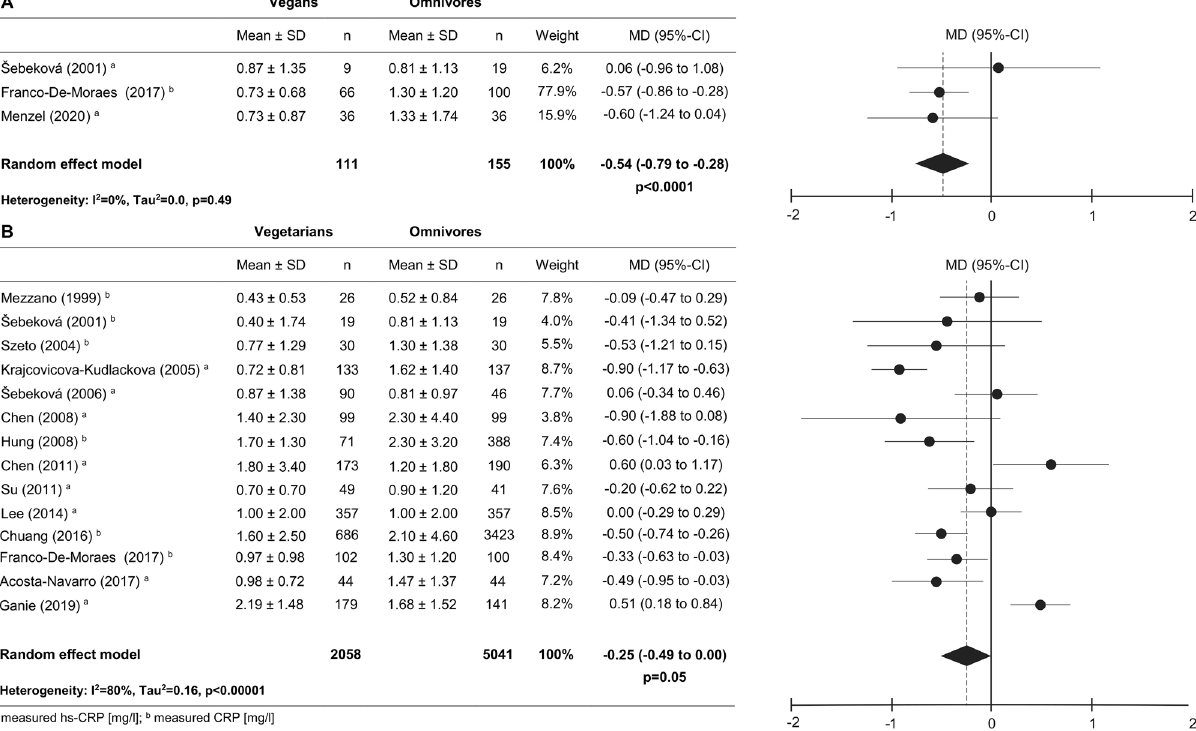
(Table 2). Among the different biomarkers, a meta-analysis was possible for CRP and TNF- ɑ in apparently healthy individuals. Regarding TNF- ɑ no significant differences between vegetarians and omnivores have been observed [mean difference 0.02 pg/ml, 95%-CI: − 0.39 to 0.43 pg/ml, p = 0.93]. However, meta-analysis revealed lower CRP levels in vegetarians compared to omnivores, showing a mean difference between vegetarians and omnivores of − 0.25 mg/l (95%-CI: − 0.49 to 0.00 mg/l; p = 0.05) (Fig. 2B). The generated funnel plot for CRP showed no evidence for publication bias (Supplemental Figure S1). In addition, also different statistical methods e.g. Egger regression or Funnel plot regression showed no evidence for publication bias (Supplemental Table S2). Interest- ingly, the association between vegetarian diet and CRP is much more pronounced in pre-diseased individuals with impaired kidney function − 3.91 mg/l (95%-CI: − 5.23 to − 2.60 mg/l; p < 0.0001) (Table 3, Supplemental Fig- ure S2). With regard to E-selectin and MCP-1, no significant differences between apparently healthy vegetarians and omnivores have been observed (Table 2). Lower levels of IL-6 have been observed by Ganie et al. ( p < 0.01) 36 ,